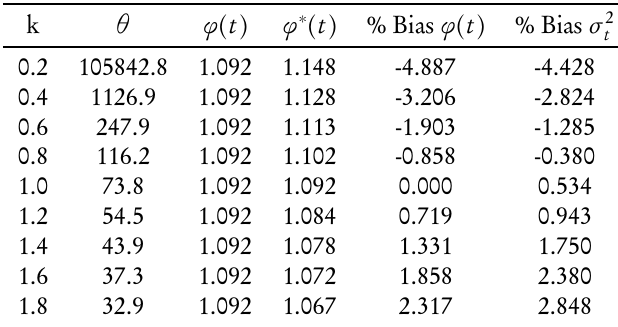
The effect of model misspecification for the censoring distribution on the variance inflation factor and the variance of the survival curve at 12 weeks. The assumed censoring distribution is exponential, while the true is Wiebull with shape k and scale θ . The table present the assumed variance inflation ( ϕ ( t ) ) the ϕ ∗ ( t ) and the expected % bias of the inflation factor and the variance of the survival at t = 12